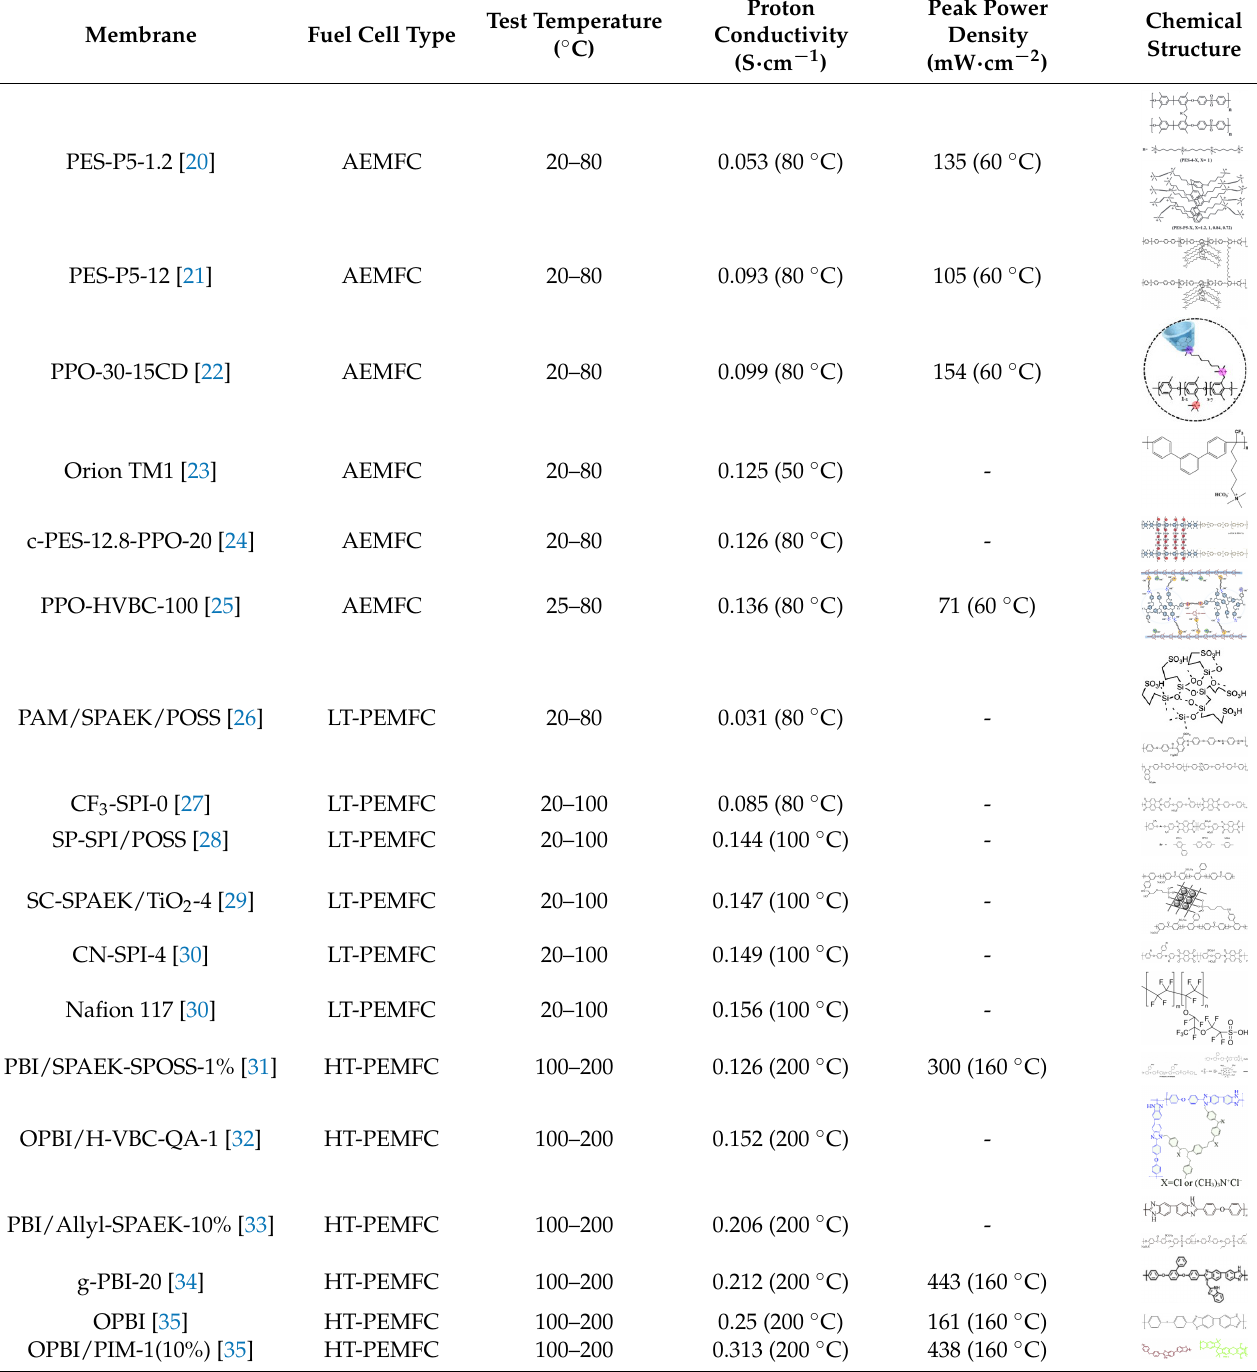
Table 1. Some examples of the polymer membranes for fuel